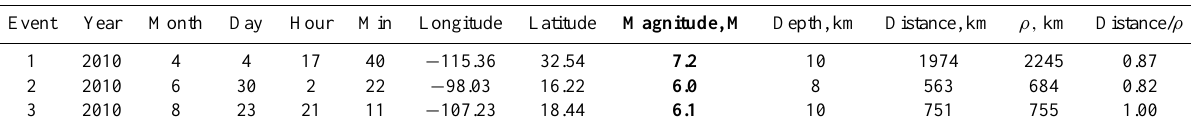
Table 1. Earthquakes occurring in Mexico during 2010 (magnitude greater than 6) selected for this analysis. Year/month/day/hour/min are: the exact time of the EQ (Local Time); Latitude and Longitude: the geographic coordinates of the epicenter; Magnitudes and Depth: magnitude and depth of the EQ; Distance: the distance between the epicenter and Juriquilla station; ρ : the radius of the EQ preparation zone estimated by the proposed equation. The EQ magnitudes are presented in bold.